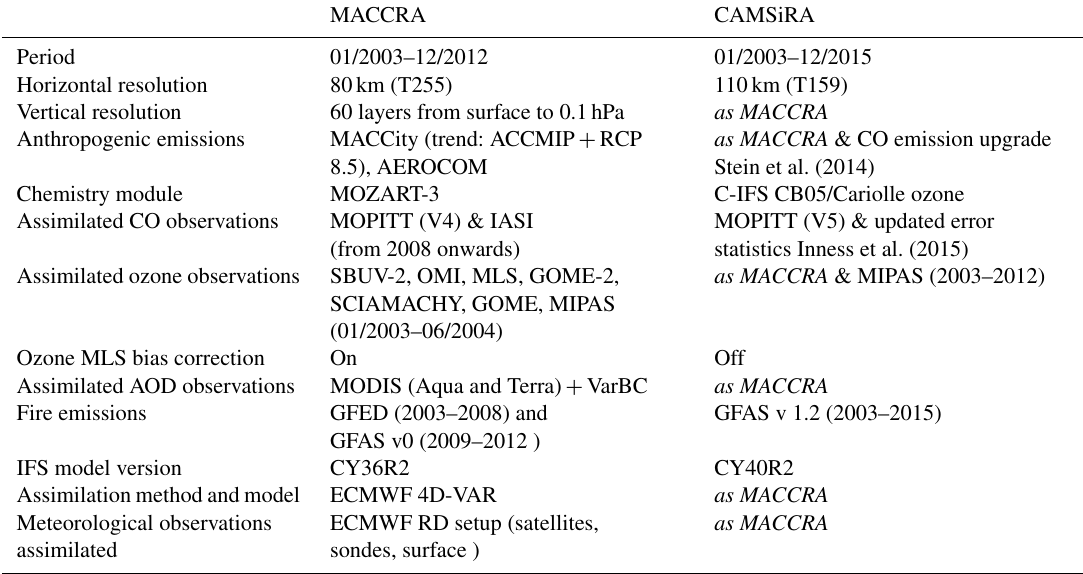
Table 1. Important commonalities and differences between MACCRA and